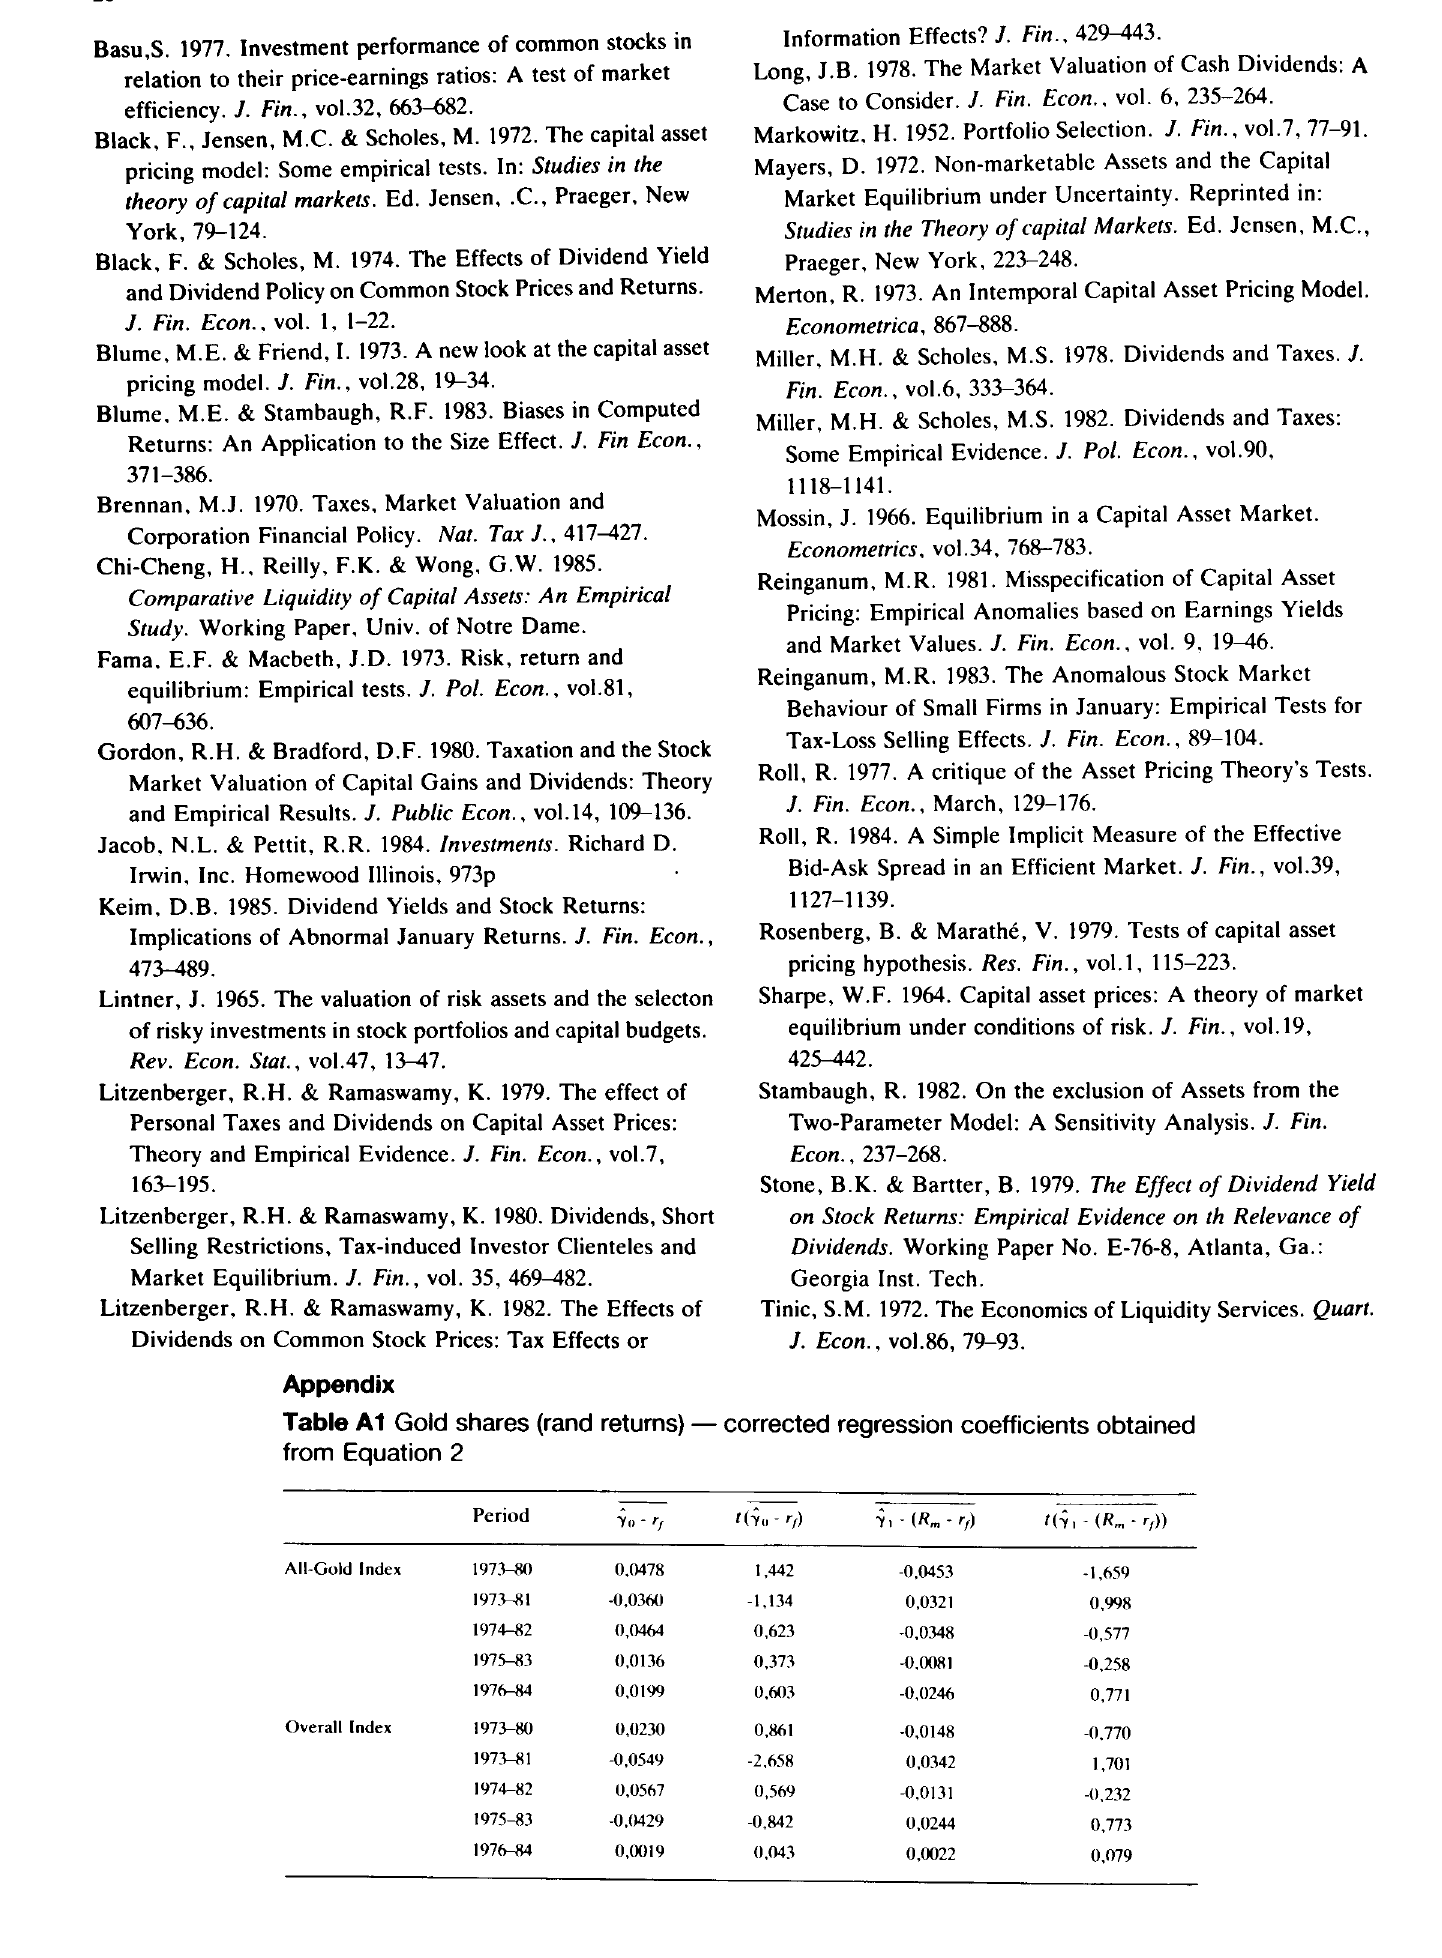
Table A 1 Gold shares (rand returns) - corrected regression coefficients obtained from Equation 2 Period